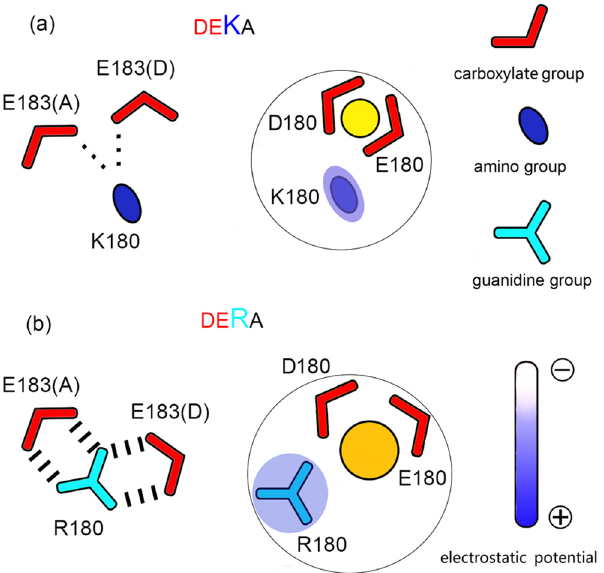
Fig 6. Diagram of the model to explain the difference in ion selectivity between the DEKA and DERA mutants. Na + and K + ions are represented by yellow and orange spheres respectively. (a) In the DEKA mutant, Lys180 side chain tends to protrude into the center of the SF, repelling the cation to bind at the Na + - preferred sub-location sandwiched by at least three carboxylate oxygen atoms of Asp180 and Glu180. (b) In the DERA mutant, because of the stable bifurcate interactions with Glu183 residues (in chain A and D), Arg180 side chain tends to line along the side wall of the SF pore. This conformational difference as well as the lower charge density on the guanidine group jointly weaken the electrostatic repulsion and allow the cation to sample the less Na + -selective or even K + -preferred sub-locations coordinated by no more than two carboxylate oxygen atoms of Asp180 and